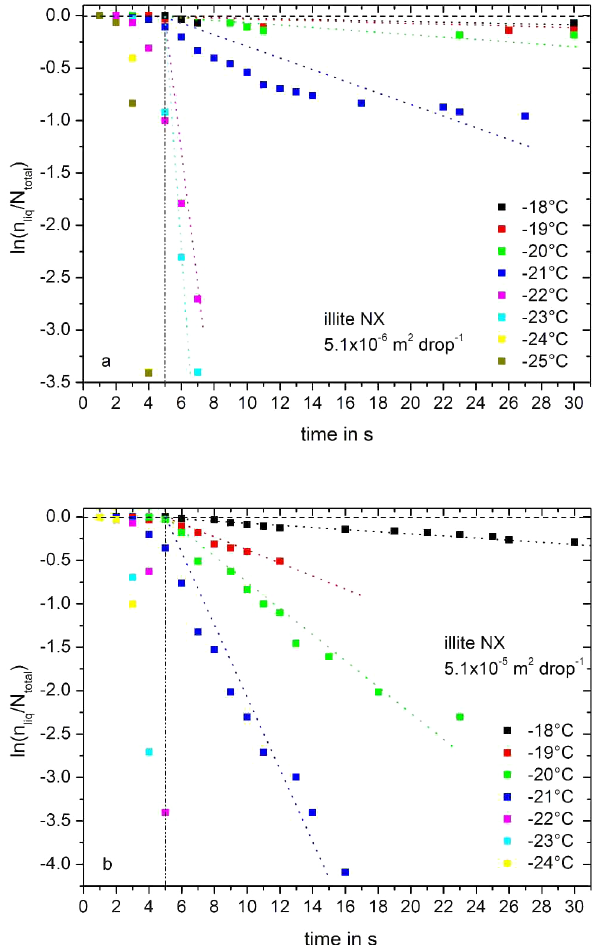
Figure 6. Liquid ratio as a function of time from wind tunnel exper- iments with illite NX at different temperatures. Vertical line: limit of adaptation time of the drops. Particle surface area 5.1 × 10 − 6 m 2 per drop (a) . Particle surface area 5.1 × 10 − 5 m 2 per drop (b) . Dot- ted lines: manually drawn starting at t =